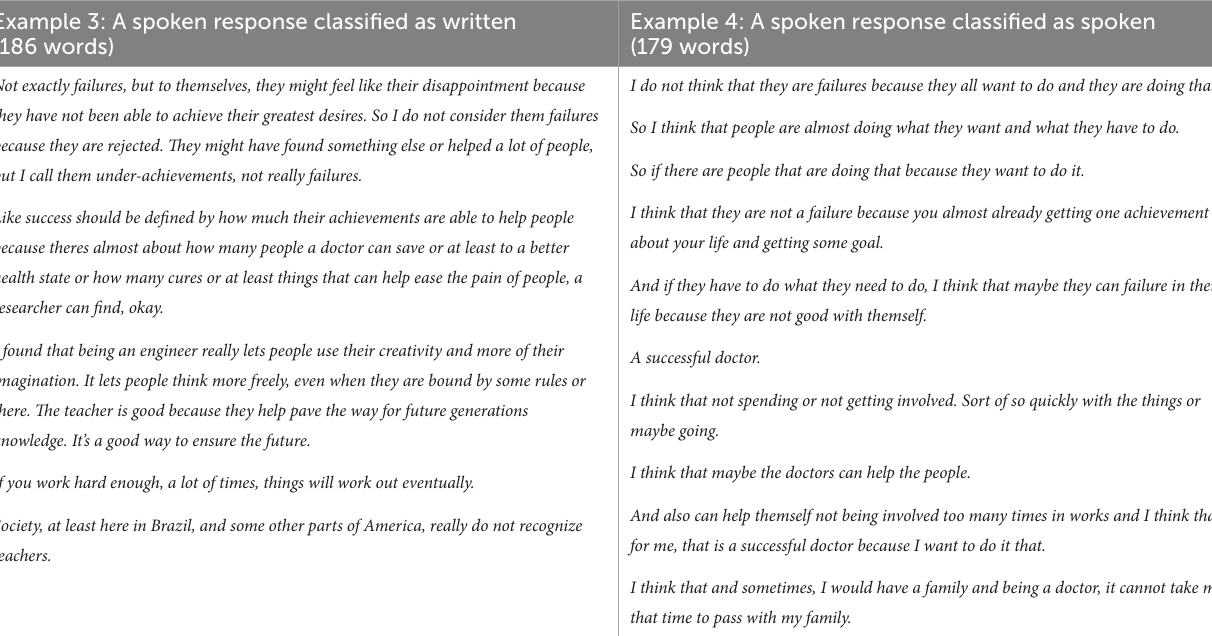
TABLE 9 Examples of L2 spoken opinion responses. Example 3: A spoken response classified as written (186 words)